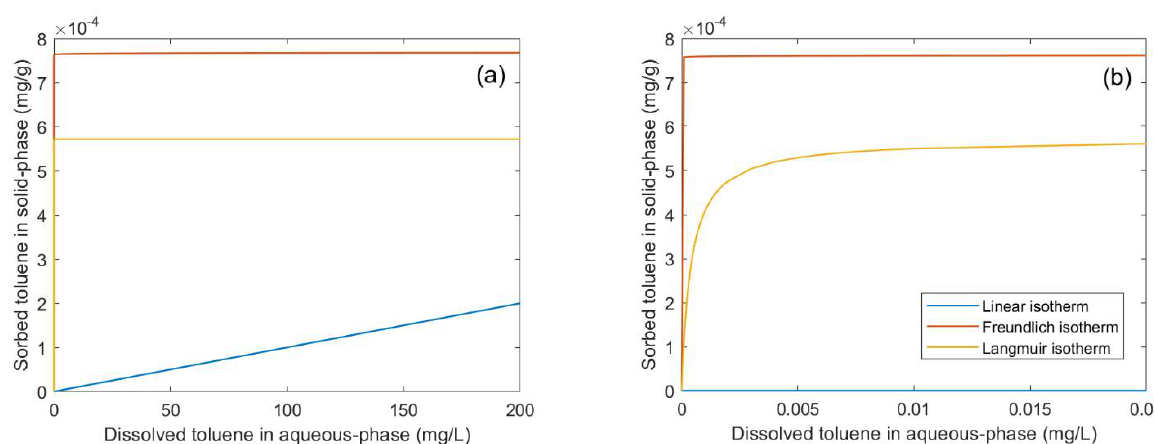
Figure 8. Estimated sorption isotherm curve in the simulation of toluene transport: ( a ) toluene concentration = 0~200 mg/L; ( b ) toluene concentration = 0~0.02 mg/L.